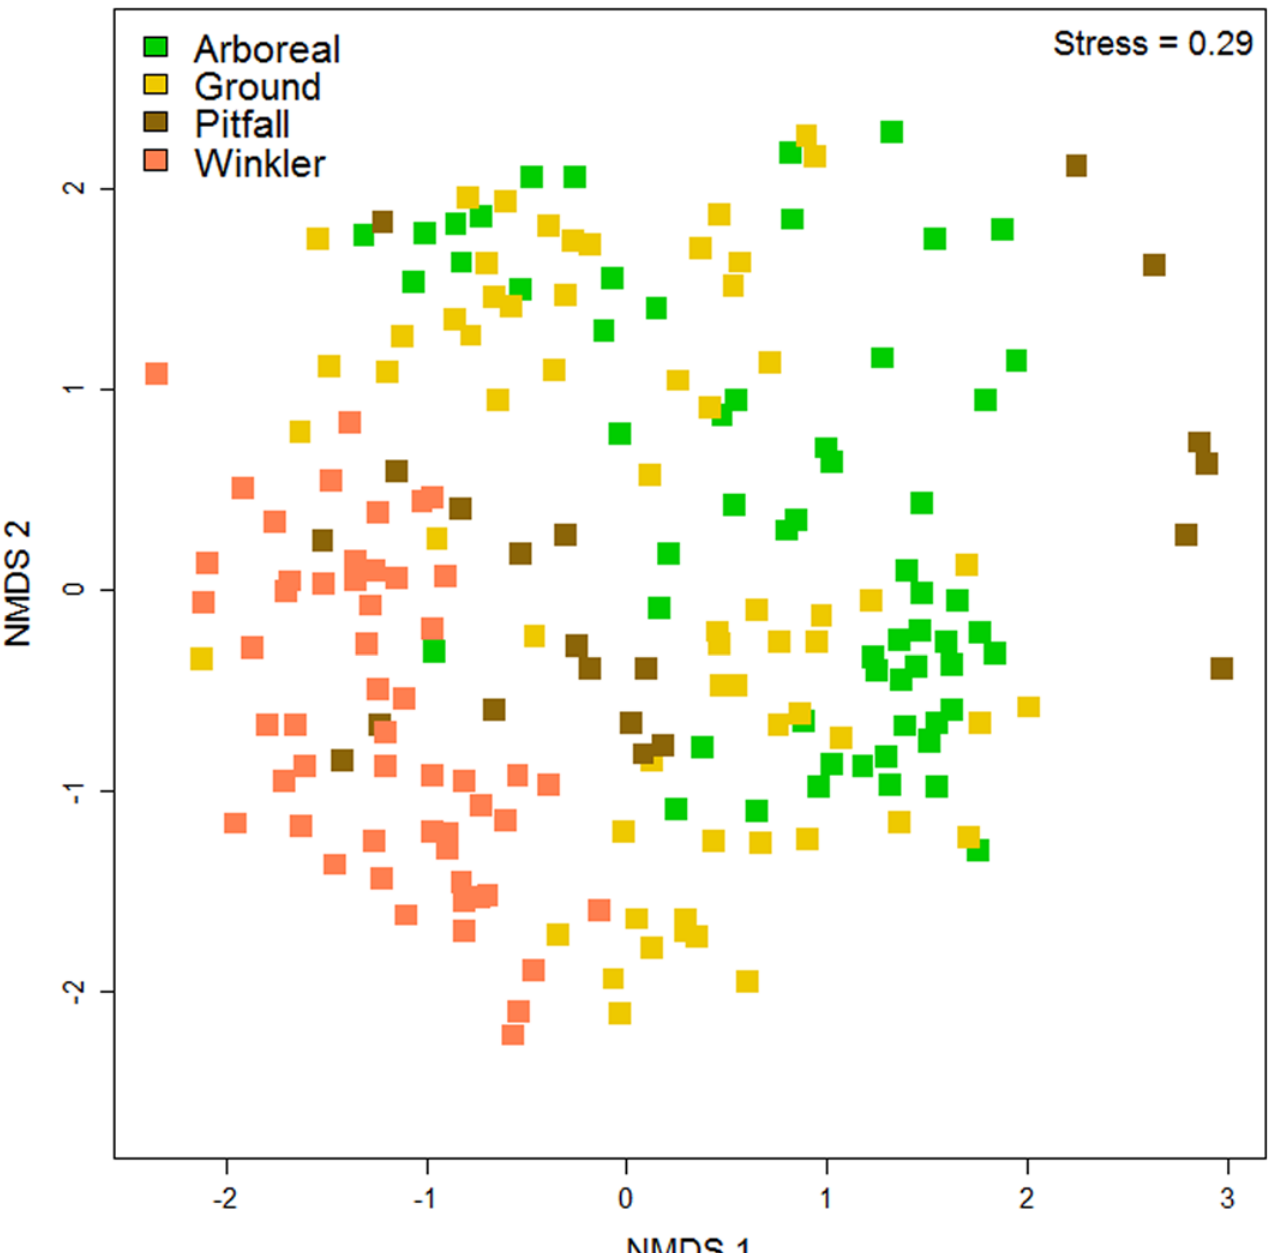
Fig 2. NMDS of samples from different techniques, based on species frequencies of occurrence. Each point represents a sample from one